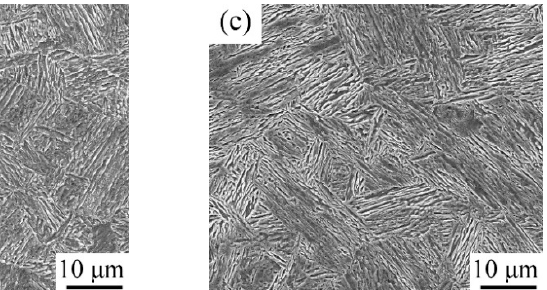
Figure 3. SEM images after being intercritically annealed at 650 °C: ( a ) 6 h; ( b ) 12 h; and ( c ) 50 h.